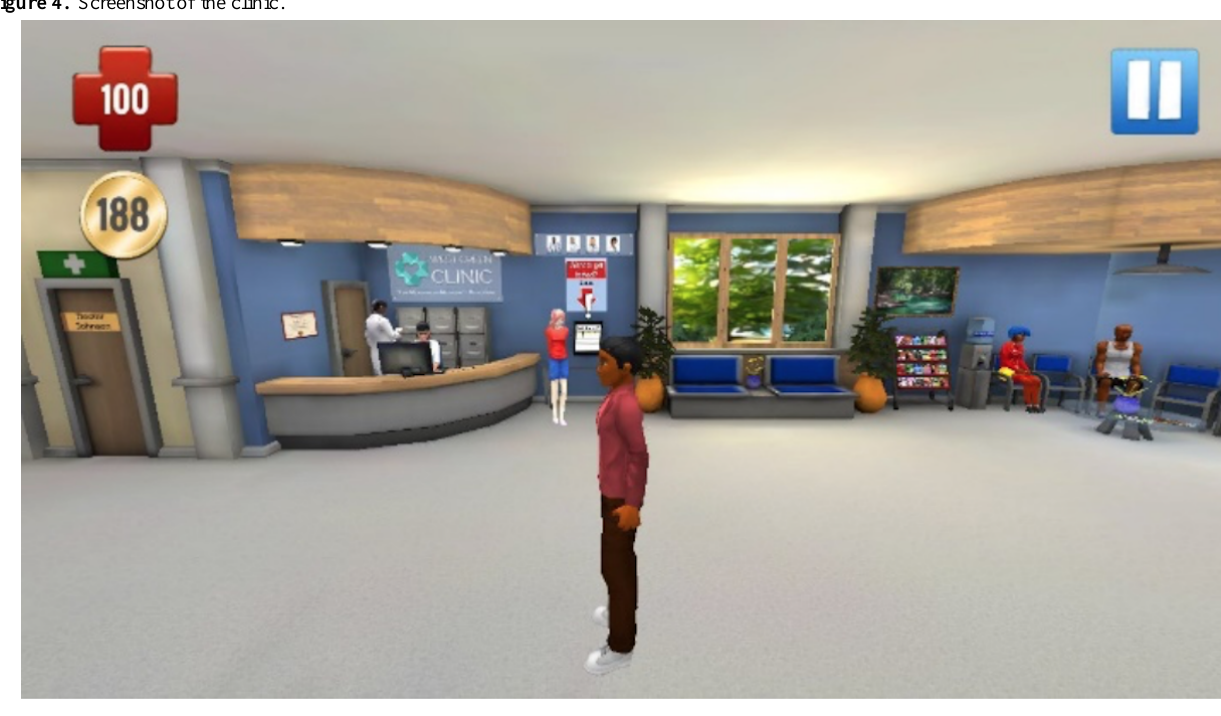
Figure 4. Screenshot of the clinic.